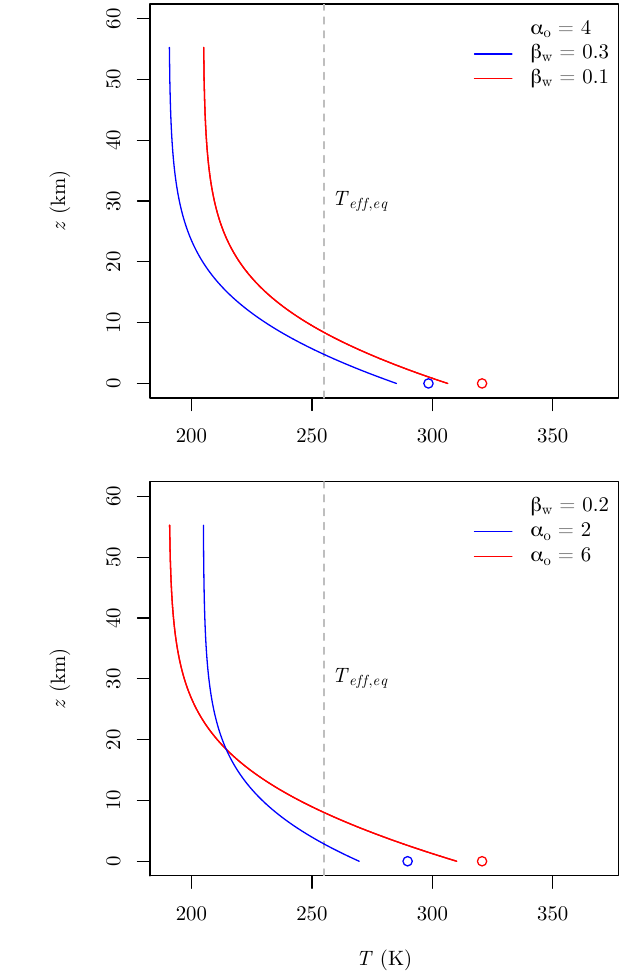
Figure 7. Vertical temperature profiles in overall equilibrium for the window-grey case with T eff,eq = 255K for different combina- tions of the parameters α o and β w (Eq. 31). The circles at z = 0 denote the corresponding surface temperatures. Note that the verti- cal coordinate z is only approximate height, calculated from h with a constant scale height H = 8km such that h = 1 − e − z/H .